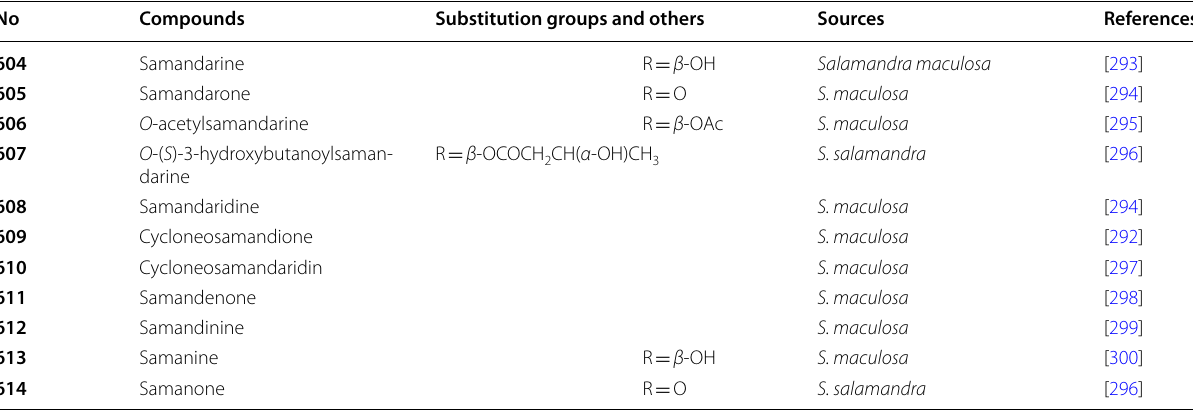
Table 12 Structures and sources of samandarines